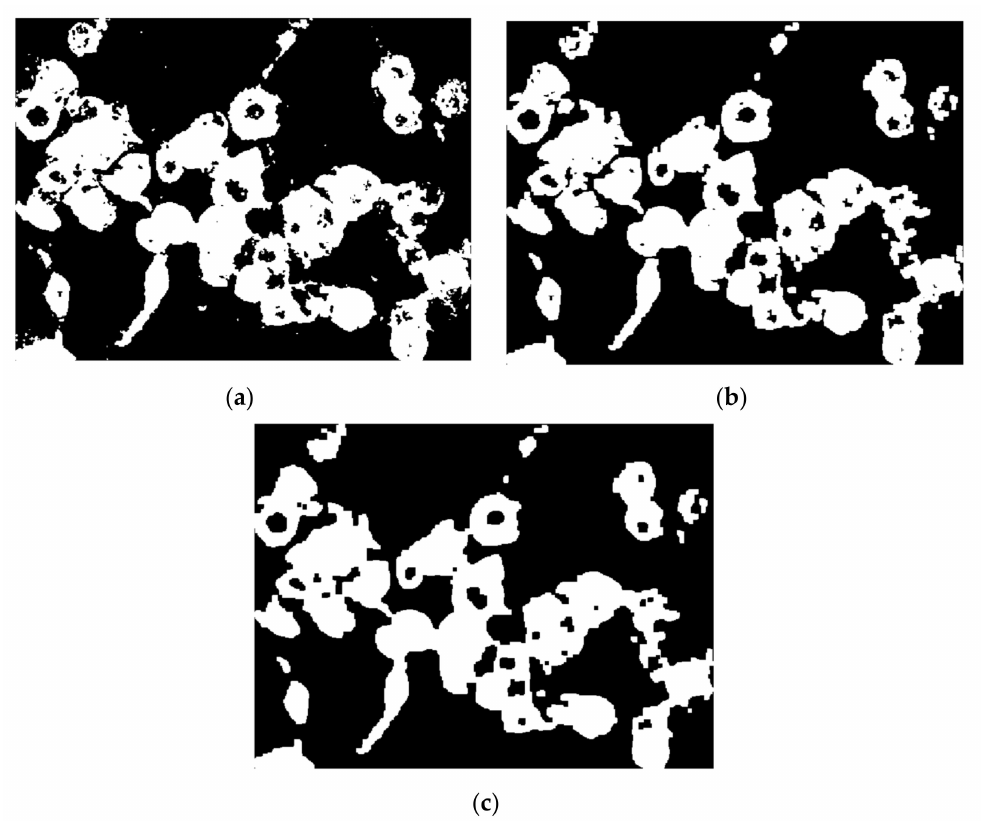
Figure 10. ( a ) Binary image; ( b ) morphological open on ( a ); ( c ) morphological close on ( b ). Relatively small stains that are inconclusive in terms of cell segmentation can be treated as noise and eliminated, allowing the number of cells calculated from the seg- mented picture to remain unaffected. Correspondingly, bwareaopen may be used to remove minor disturbances within the cell area, first removing white foreground regions from the dark background. Then, since cells are in the front, small black patches inside molecular regions are created by complementing and removed. In this case, all regions smaller than a selected parameter of 50 pixels were eliminated from the